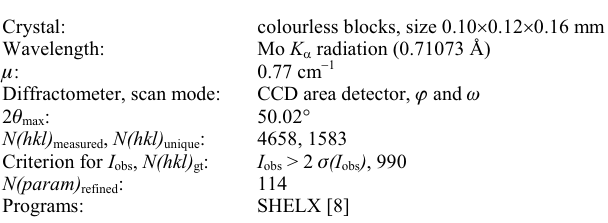
Table 1. Data collection and handling.